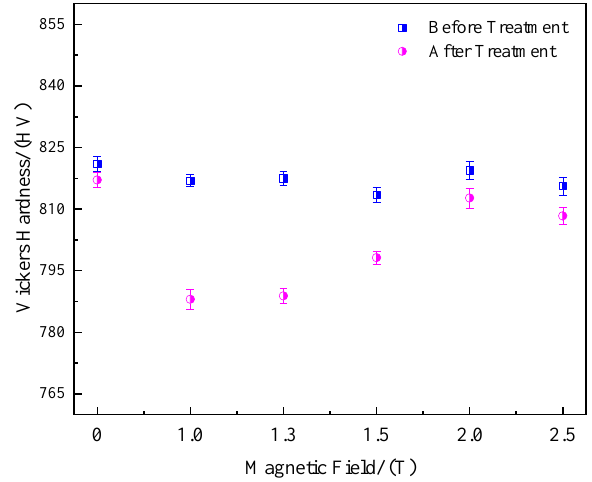
Figure 10. Average value of Vickers hardness before and after treatment at different magnetic fields.